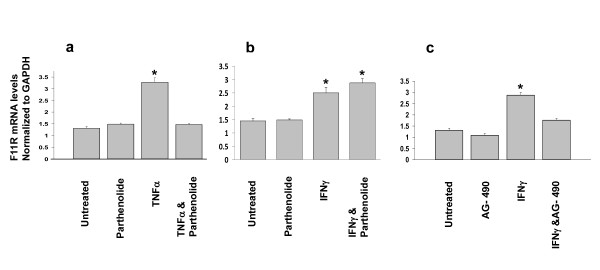
Upregulation of F11R mRNA expression by TNFα and INFγ in endothelial cells: inhibition by the NF-kB blocker and JAK protein kinase inhibitor. Panels (a) and (b). Confluent monolayers of HUVEC were pretreated (or Untreated) for 1 hr at 37°C with the NF-kB inhibitor, parthenolide (50 μM, final concentration), added to growth supplement-free media. The proinflammatory cytokines, TNFα (100 u/mL) or IFNγ (200 u/ml), were added to the media, and the cells were incubated at 37°C for an additional 24 hrs (see TNFα & Parthenolide in Figure 4a, and IFNγ & Parthenolide in Figure 4b). The response of cells exposed only to TNFα alone (100 u/ml) is shown in the histogram displayed in Figure 4a, and the response of cells exposed only to IFNγ alone is shown in Figure 4b. The F11R mRNA levels were measured by Real-time PCR performed in triplicate for each condition. Values are the mean ± SEM. * P < 0.05 level of significance observed between ECs exposed to TNFα or IFNγ alone vs ECs not exposed to TNFα/INFγ or ECs previously treated with parthenolide followed by their exposure to cytokines. Figure 4c demonstrates the upregulation of F11R mRNA in endothelial cells by IFNγ and its inhibition by the JAK protein kinase inhibitor, AG-490. Confluent monolayers of HUVEC were either Untreated or treated with the JAK protein kinase inhibitor AG-490 (50 μM) alone (AG 490) added to growth supplement-free media and incubated for 1 hr at 37°C. The response of cells that were exposed to the cytokine IFNγ alone is depicted in the histogram IFNγ. The response of cells that were pretreated with AG 490 for 1 hr followed by their exposure to IFNγ (200 u/mL) for an additional 24 hrs is depicted in histogram labeled IFNγ & AG-490. The F11R mRNA levels were measured by Real-time PCR performed in three separate experiments, in triplicate, for each condition. Values are the mean ± SEM. * P < 0.05 significance differences in F11R mRNA in ECs exposed to IFNγ alone vs untreated ECs or ECs treated with AG-490 alone or ECs previously treated with AG-490 followed by their exposure to IFNγ